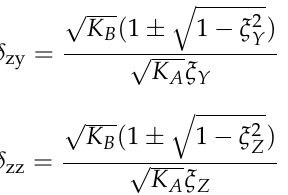
Table 2. Projectile parameters and initial conditions.